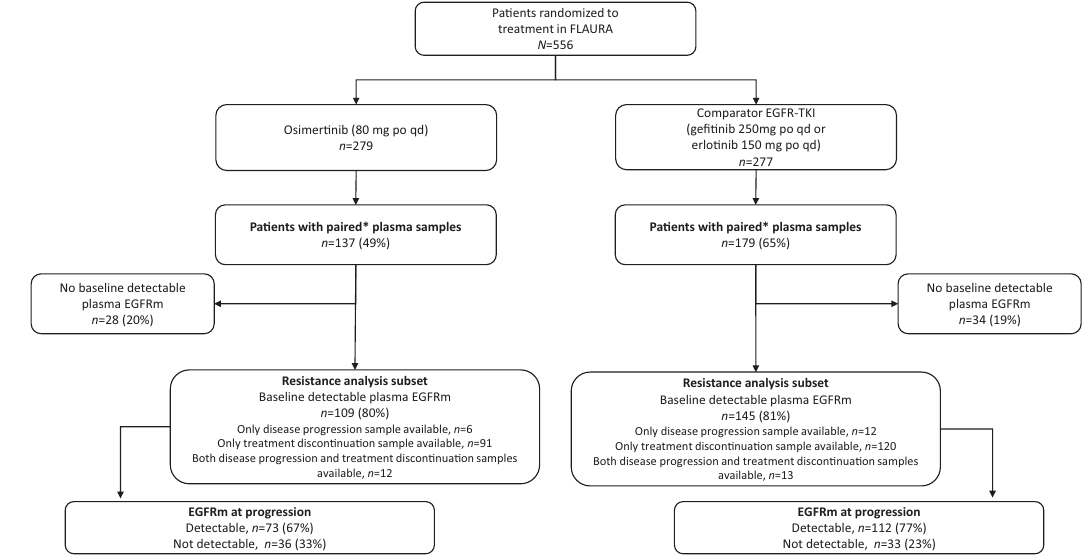
Fig. 1 | Patient disposition. CONSORT fl ow diagram of patient disposition and eligibility in the analysis of acquired resistance mutations in the FLAURA trial *Plasma provided at baseline and at disease progression or treatment